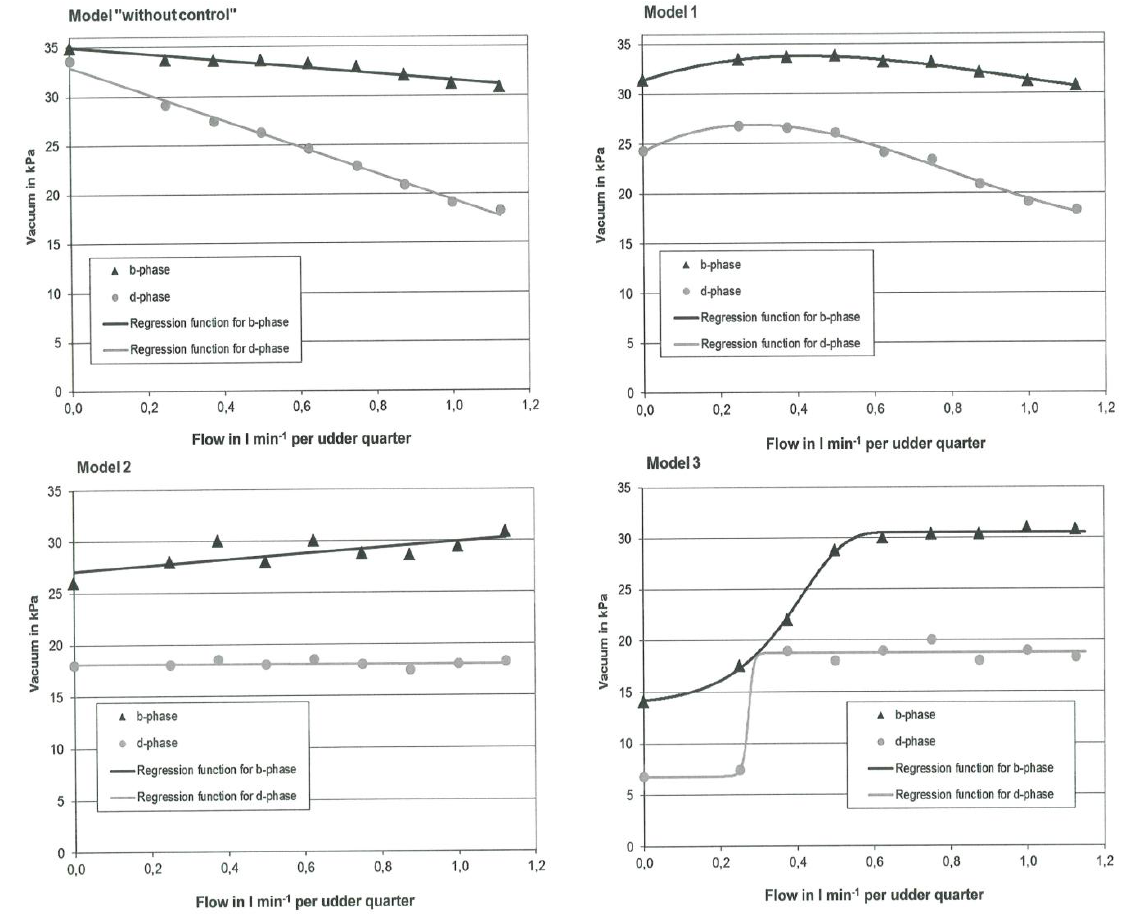
Figure 6. Vacuum behaviour in MULTI, depending on the flow rate per minute, per udder quarter, with the four possible models of the developed vacuum control system [26].